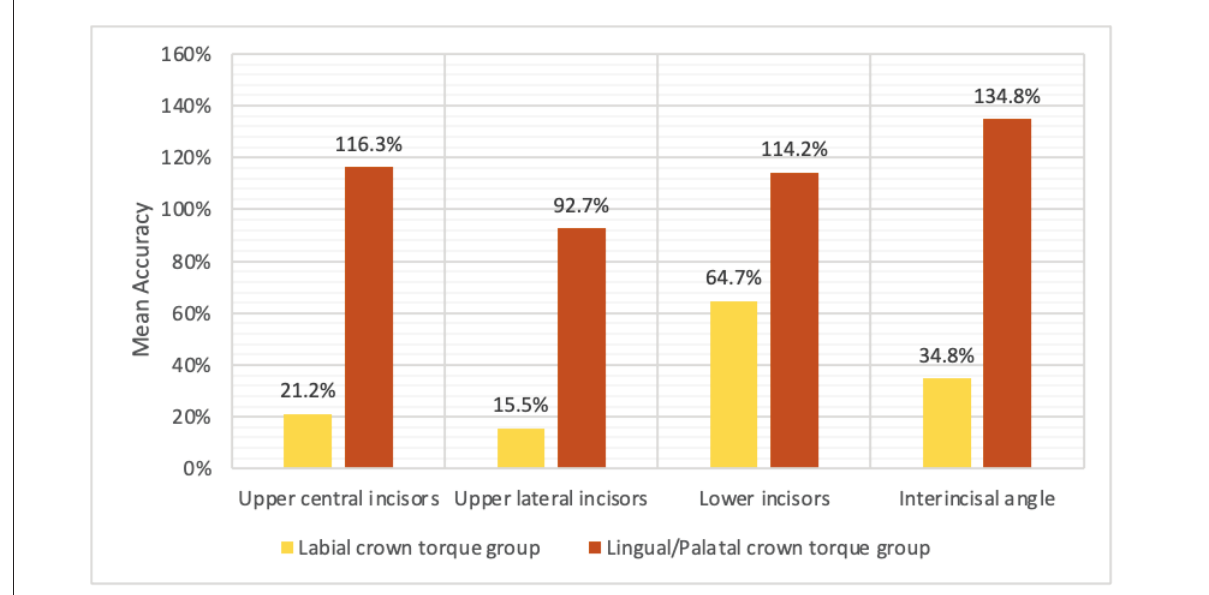
Figure 8. Mean accuracy of the torque expression and interincisal angle change resulting from prescribed